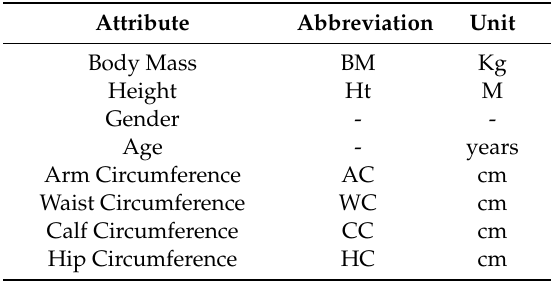
Table 1. Entry attributes in our